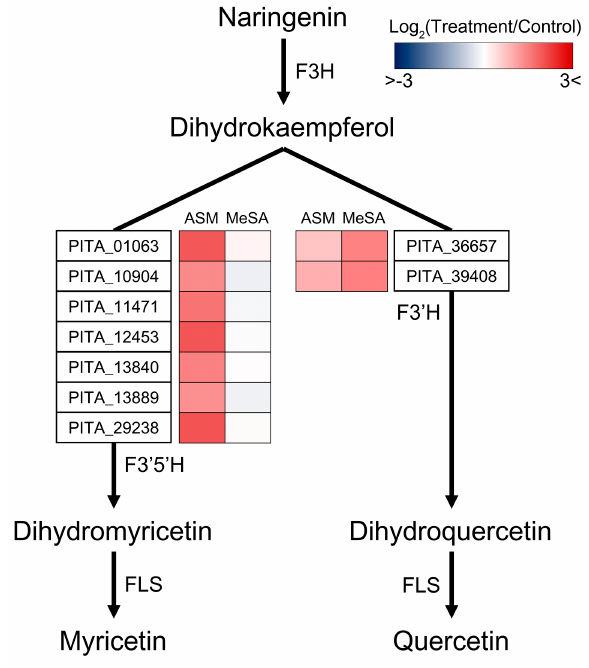
Figure 6. Schematic diagram of flavonol biosynthesis-related genes showing unique expression patterns. The biosynthetic diagram for the production of myricetin and quercetin from naringenin has been modelled. In the acibenzolar- S -methyl (ASM)- and methyl salicylic acid (MeSA)-specific patterns, the expression levels of genes have been calculated according to the log 2 (treatment / control) values and are shown as heatmaps. Each coloured cell marked in red indicates upregulation and each cell in blue indicates downregulation. Abbreviations: F3H, naringenin 3-dioxygenase; F3 ′ 5 ′ H, flavonoid 3 ′ ,5 ′ -hydroxylase; F3 ′ H, flavonoid 3 ′ -monooxygenase; FLS, flavonol synthase.